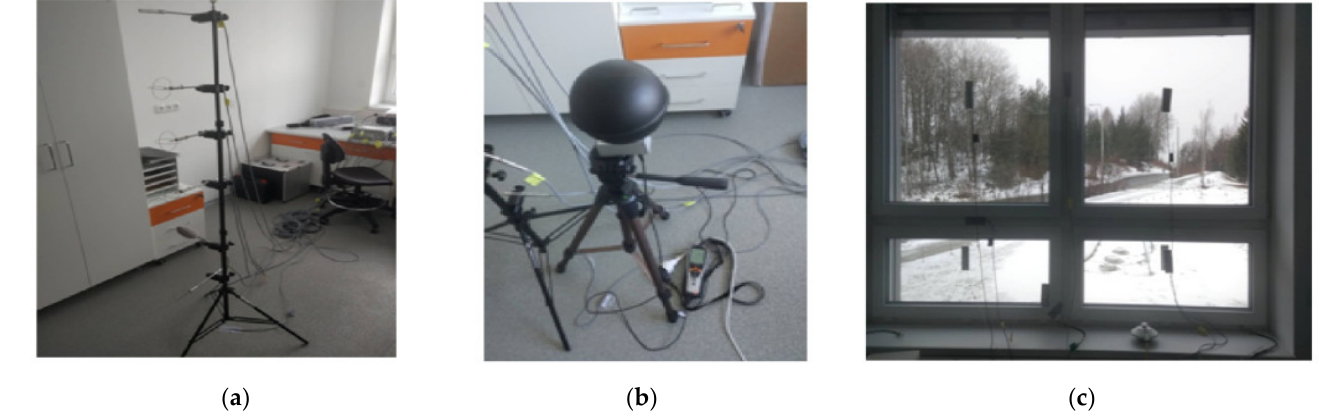
Figure 3. Indoor instrumentation: ( a ) ComfortSence measuring device, ( b ) globe temperature probe, and ( c ) Pt100 sensors for window surface temperature measurement. Table 2. Summary table of the